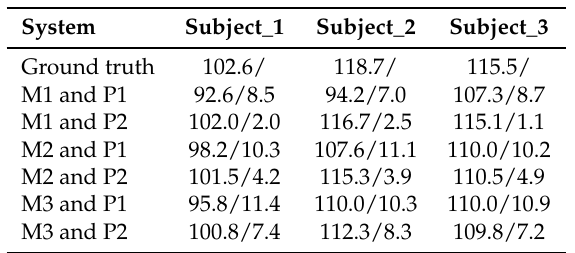
Table 5. Mean and errors of heart rates in BPM estimated by different methods when subjects performed strenuous exercise (pushups). “M1 and P2” represents the results of the proposed system. The values to the right of the/represent errors.